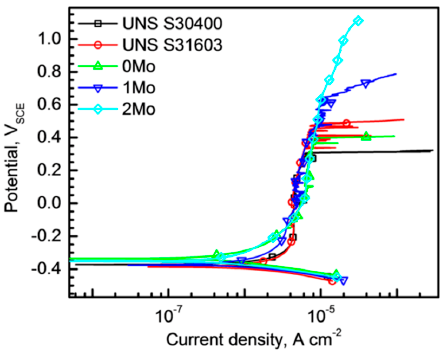
Figure 3. Linear potentiodynamic polarization curves of 0Mo, 1Mo, and 2Mo alloys and UNS S30400 and UNS S31603 alloys measured in 1 M NaCl solution at 25 °C (d V /d t = 1 mV/s).